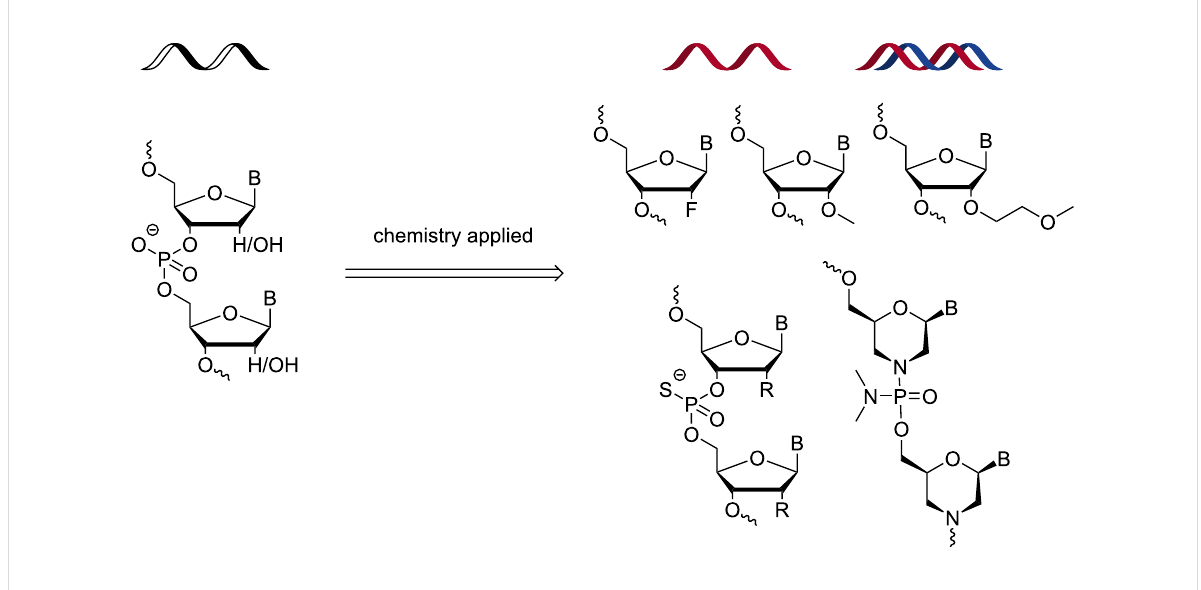
Figure 1: Introduction of chemically modified nucleotides into oligonucleotides is an essential part of their development as therapeutics.